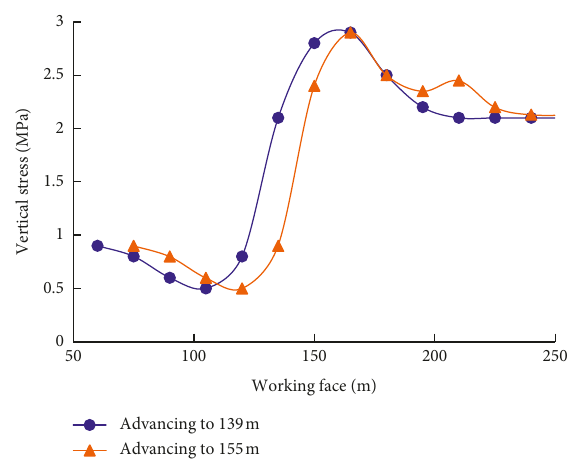
Figure 10: Distribution of vertical stress on the coal seam